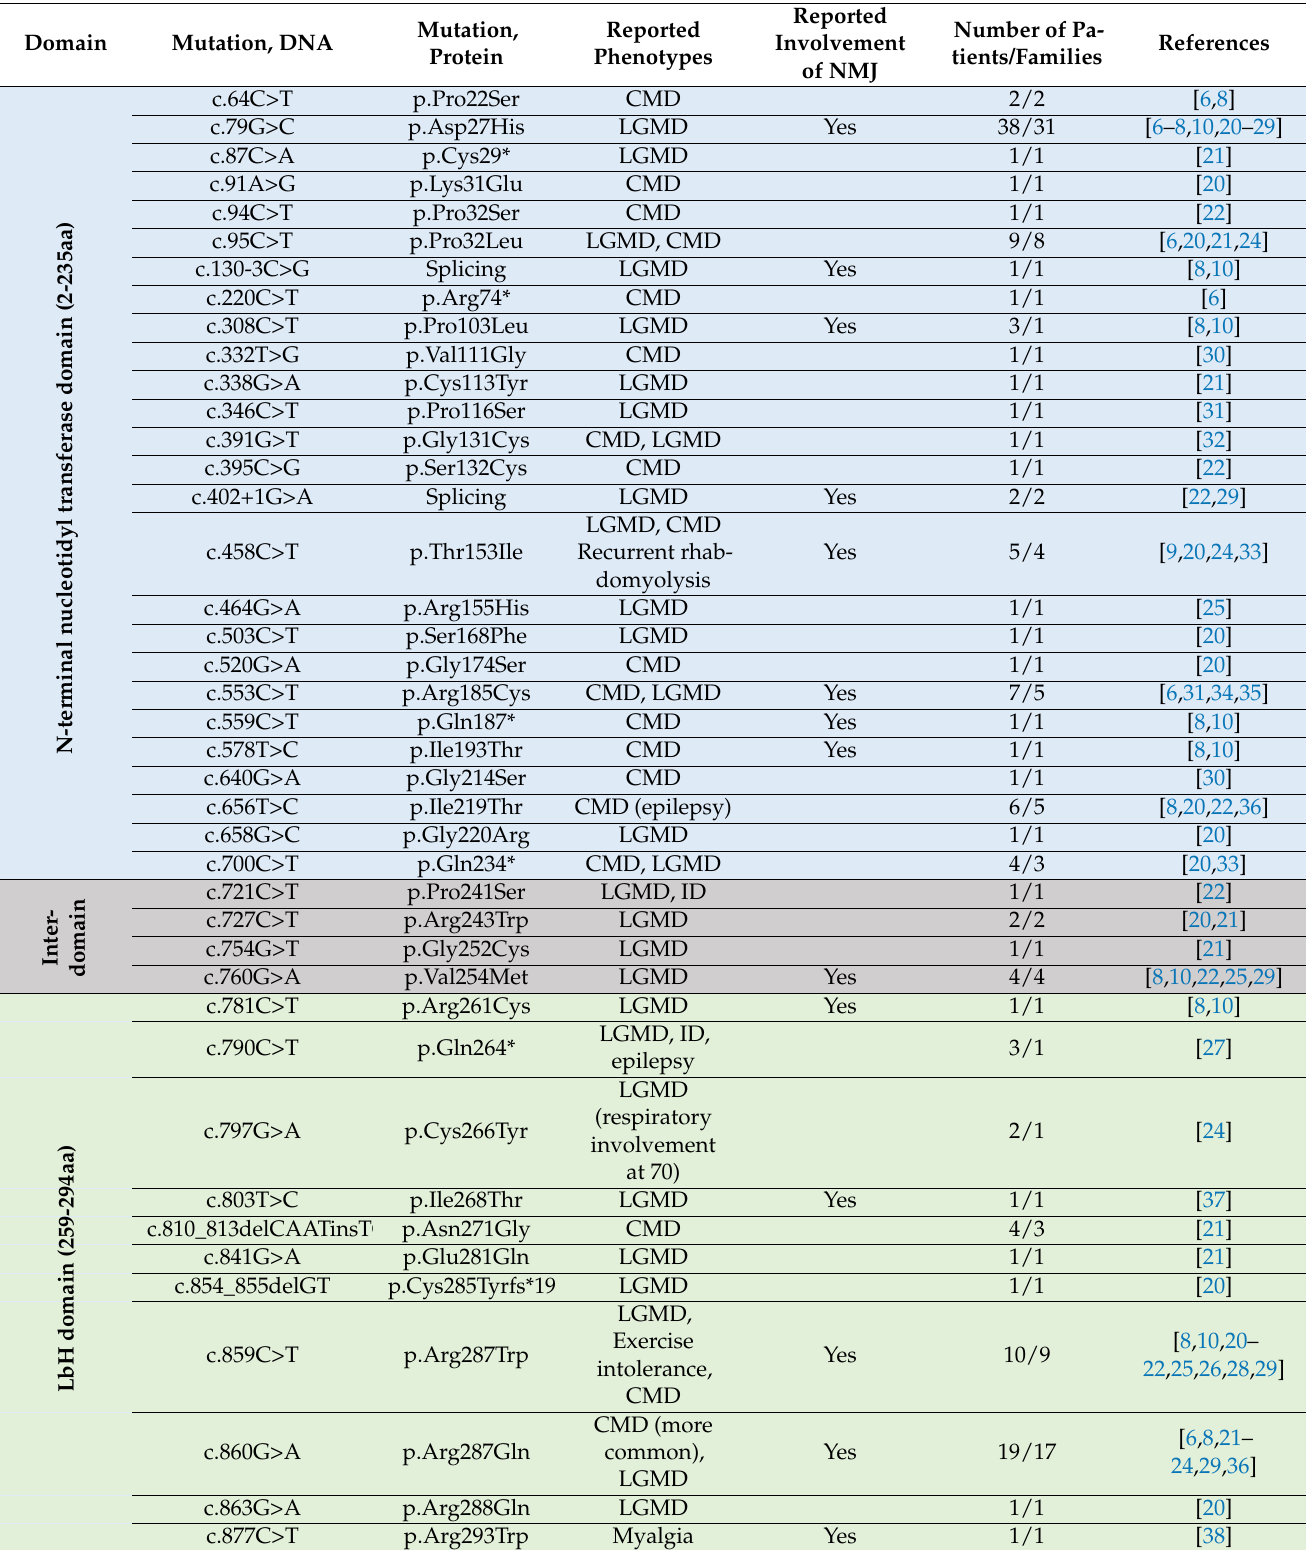
Table 1. Reported GMPPB mutations and associated